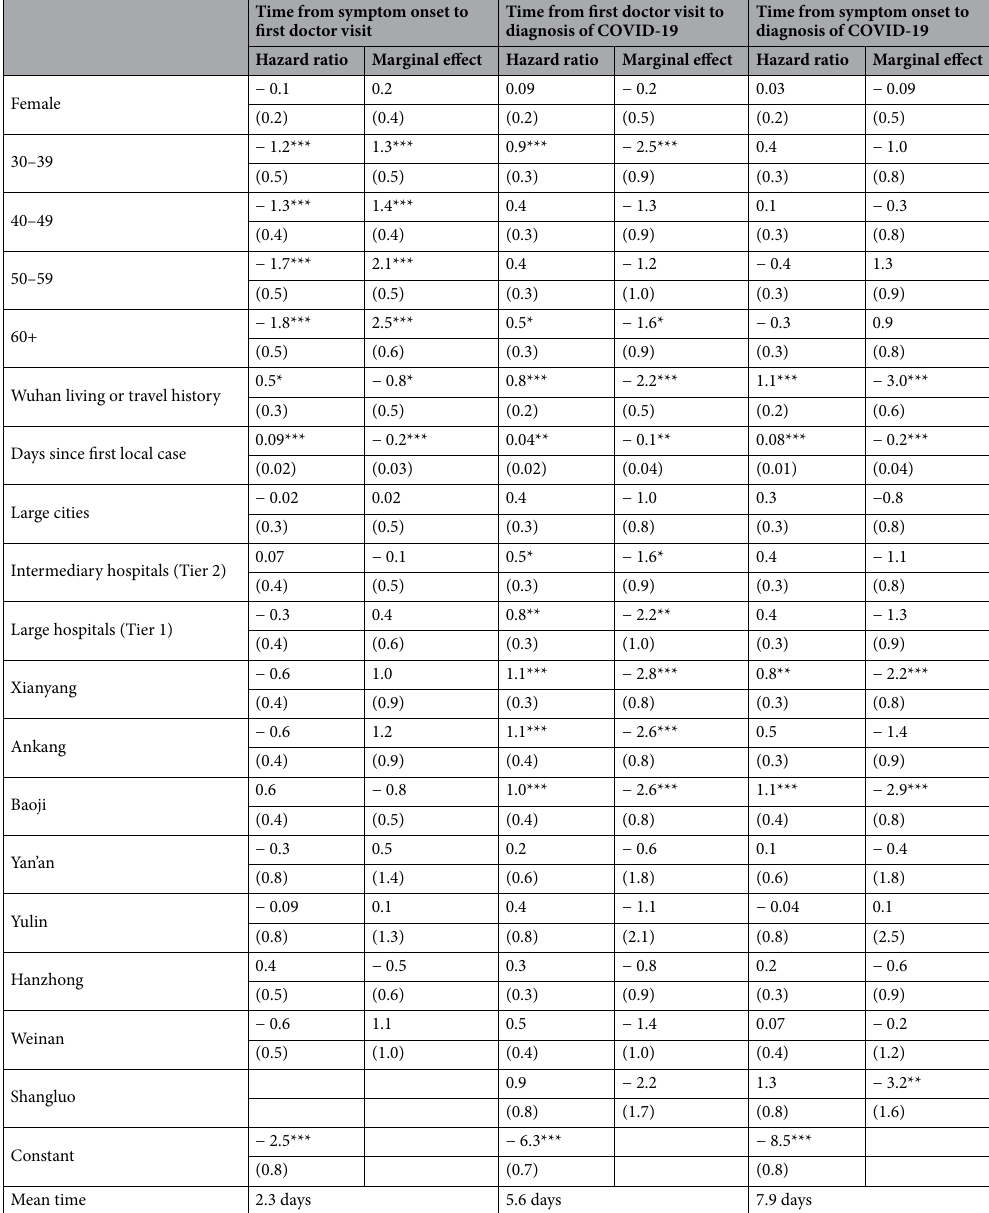
Table 3. Factors associated with time from symptom onset to first doctor visit and diagnosis of COVID- 19 infection (with age groups). * p < 0.1 , ** p < 0.05 , *** p < 0.01 . Results are estimated using a Weibull parametric specification and a sample of N = 165 . Large cities is a dichotomous variable that takes the value 1 if an individual lives in a city and 0 otherwise (living in counties or rural area). Tongchuan has no confirmed cases in this working sample. Marginal effects of risk factors to median time-to-events are